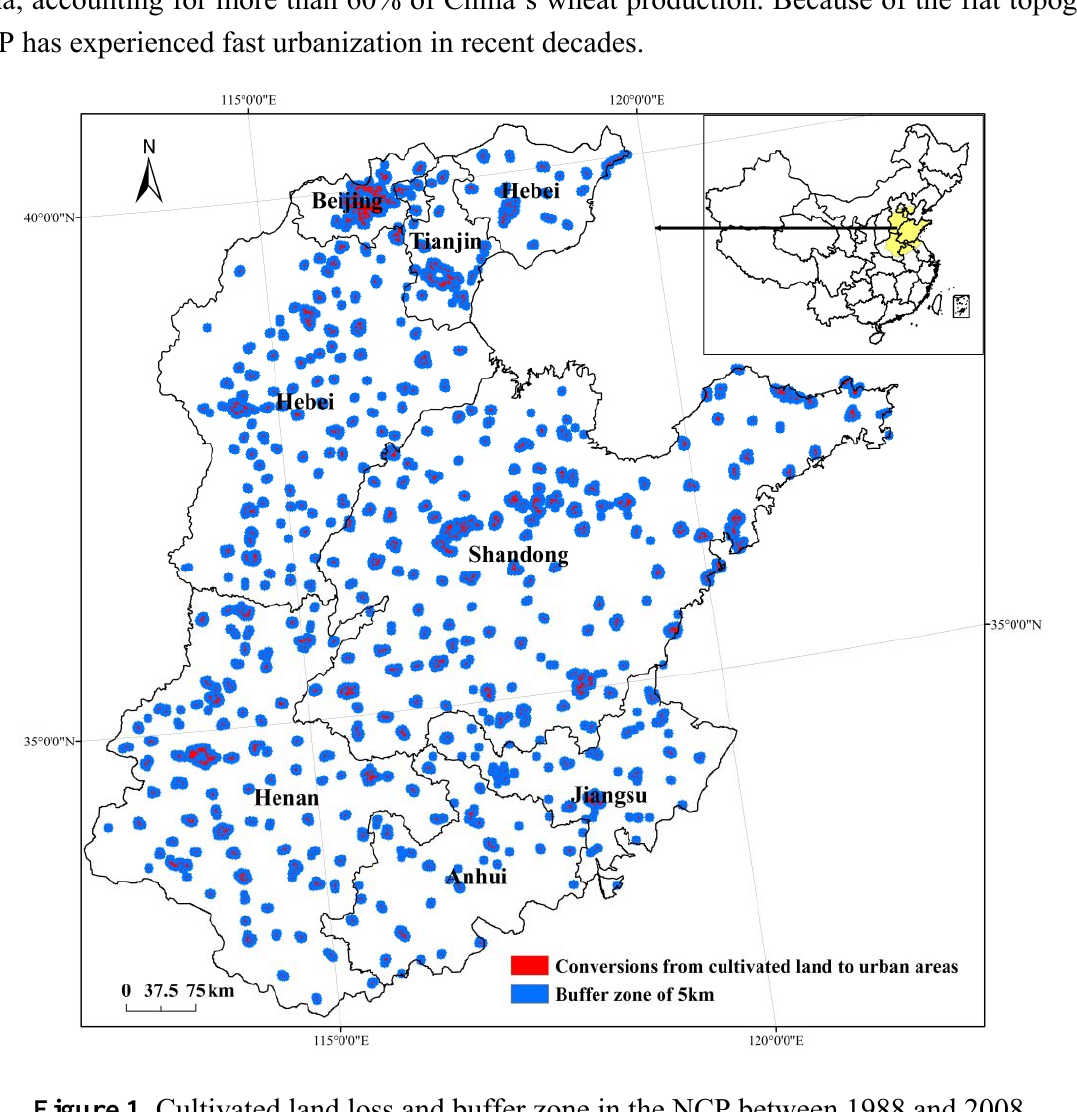
Figure 1. Cultivated land loss and buffer zone in the NCP between 1988 and